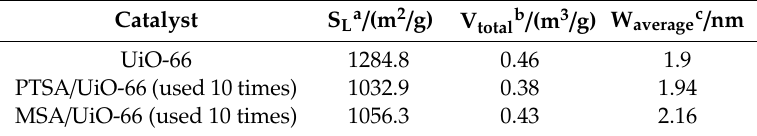
Table 3. Physicochemical properties of the used catalysts.